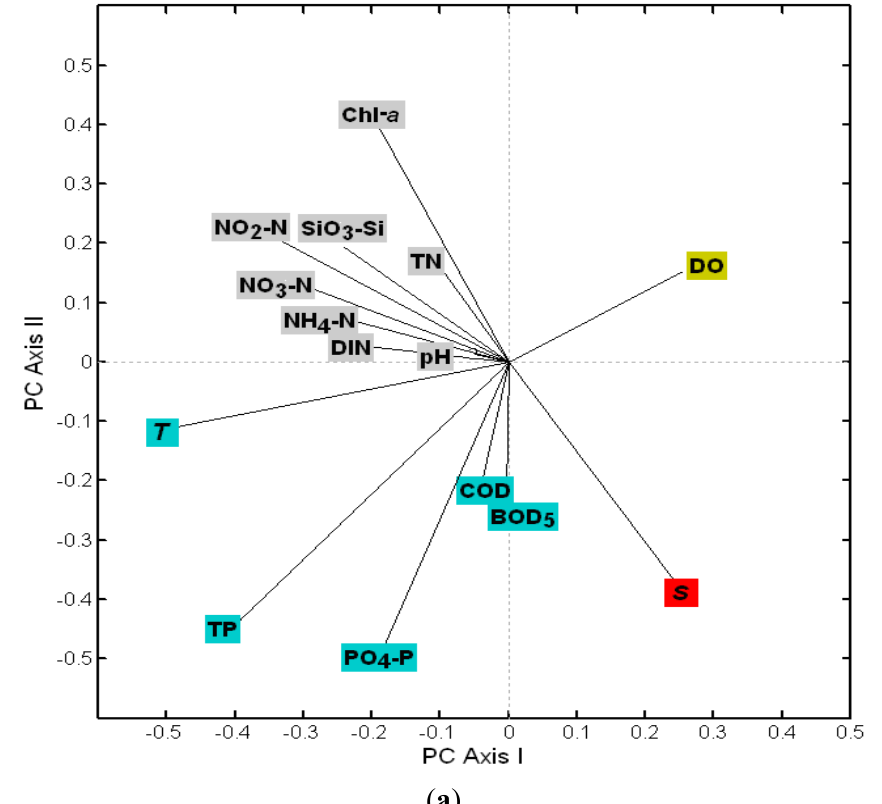
Figure 6. Principal component analysis (PCA) (Axis I and II) made on the loadings of environment variables ( a ) and the scores of the 12 station in four seasons ( b ) in